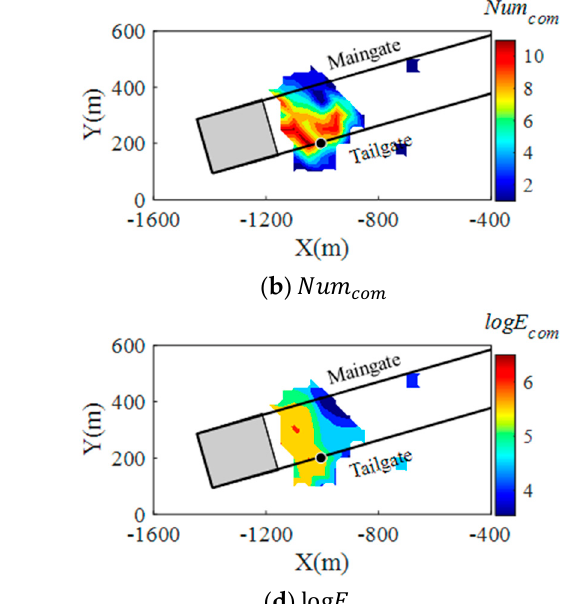
Figure 12. Contours of event counts and seismic energy levels on 31 May 2014 by using raw seismic data ( a , c ) and compensated seismic data ( b , d ) from 25 May and 31 May 2014. The black dots represent a 100-kJ seismic event that occurred on 1 June 2014, and the grey zone represents the goaf behind the longwall face.